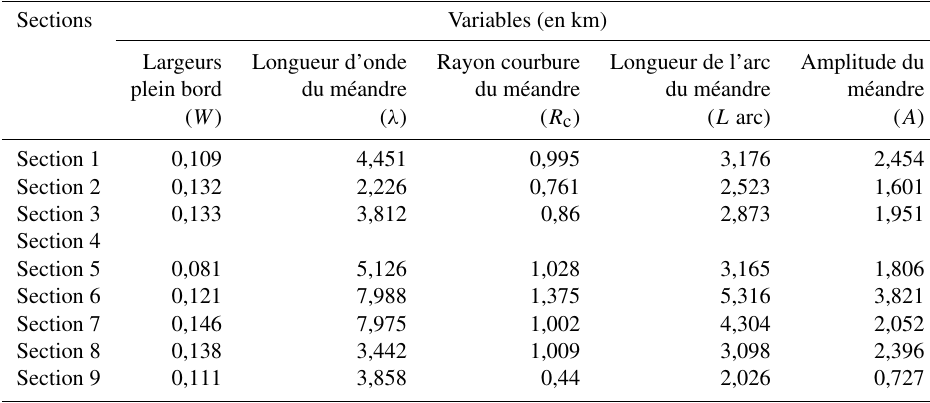
Tableau 1. Caractéristiques morphométriques des méandres en 1975.